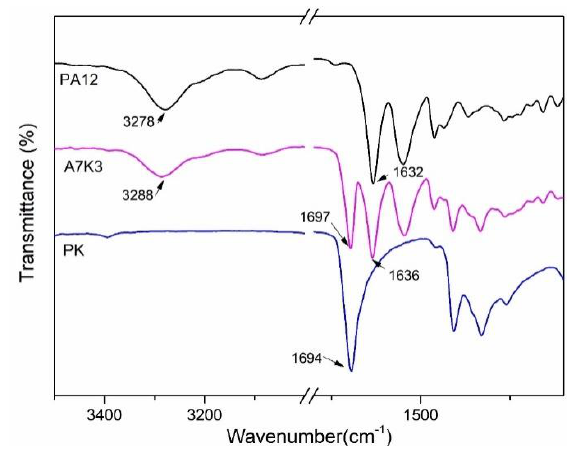
Figure 5. Fourier Transform Infrared Spectroscopy (FTIR) spectra of PA12, PK and the blend A7K3.